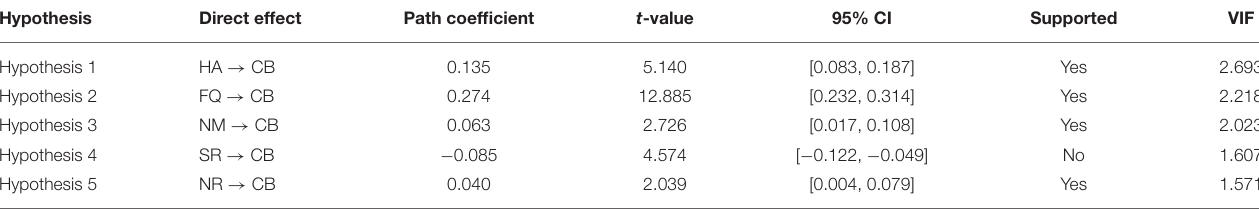
TABLE 5 | Results of hypothesis